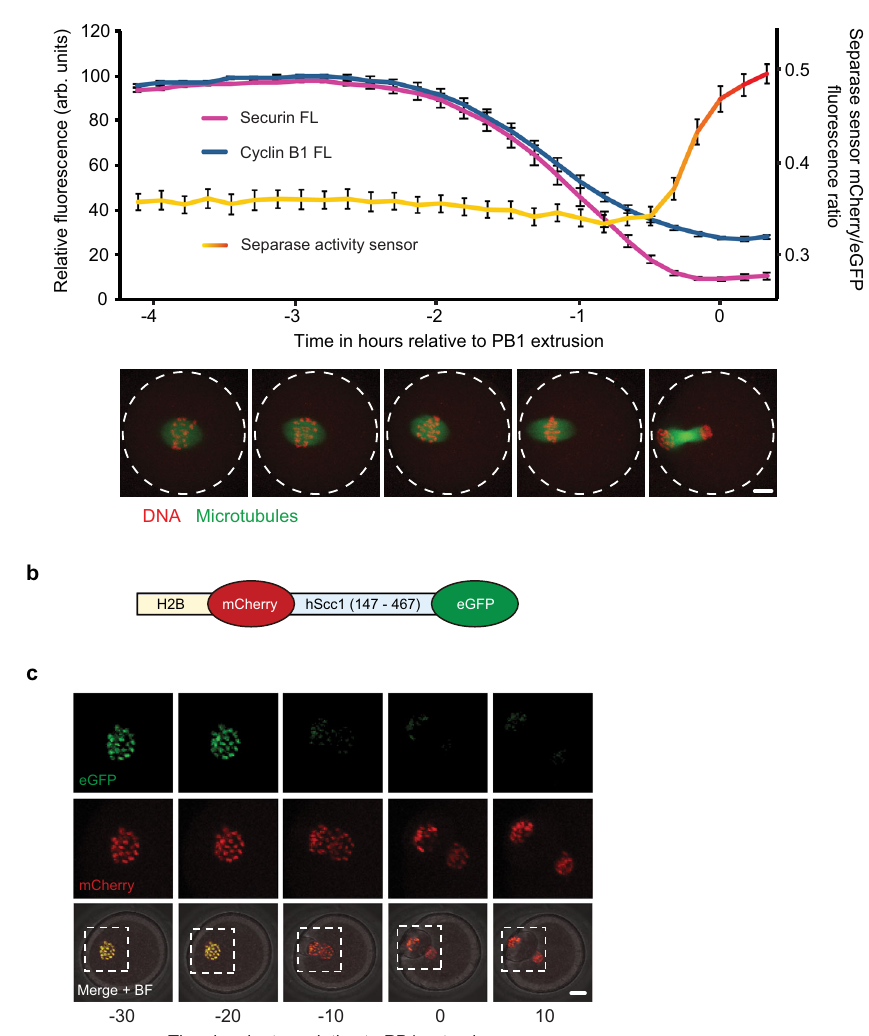
Fig. 1 Securin destruction begins 2 hours ahead of separase activation in mouse oocyte meiosis I. a Graph showing the mean destruction pro fi les of VFP- tagged securin FL (magenta trace, n = 25) and cyclin B1 FL (blue trace, n = 62) alongside separase activity as determined by a separase activity biosensor (mCherry/eGFP ratio, n = 21) in MI mouse oocytes relative to PB1 extrusion. Error bars ± SEM. Representative confocal images show a maturing oocyte expressing Map4-GFP (microtubules in green) and incubated with SiR-DNA (DNA in red) at times relative to the x axis of the graph. Scale bar = 10 µ m. b Schematic diagram of an H2B-mCherry-Scc1-eGFP separase activity biosensor. c Representative time-lapse images of an oocyte expressing the separase activity biosensor in Fig. 1b, imaged every 10 minutes at the times indicated relative to PB1 extrusion. eGFP (green), mCherry (red) and merged fl uorescence + bright- fi eld (BF) images are shown. Scale bar = 10 µ m. eGFP and mCherry images correspond to the areas marked by the white dotted lines in the merge + BF images. Images displayed in a and c are representative of between 10 and 20 oocytes from experiments repeated at least three